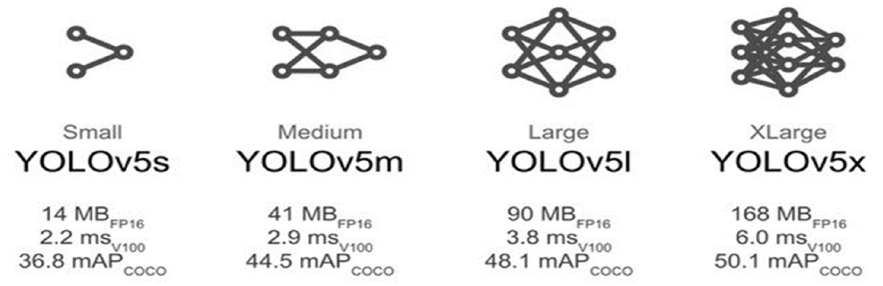
Figure 7. YOLOv5 different model sizes, where FP16 is the half floating ‐ point precision, v100 stands for the inference time in milliseconds on the NVIDIA V200 GPU, and mAP (mean average precision) is calculated according to the original COCO dataset [30].